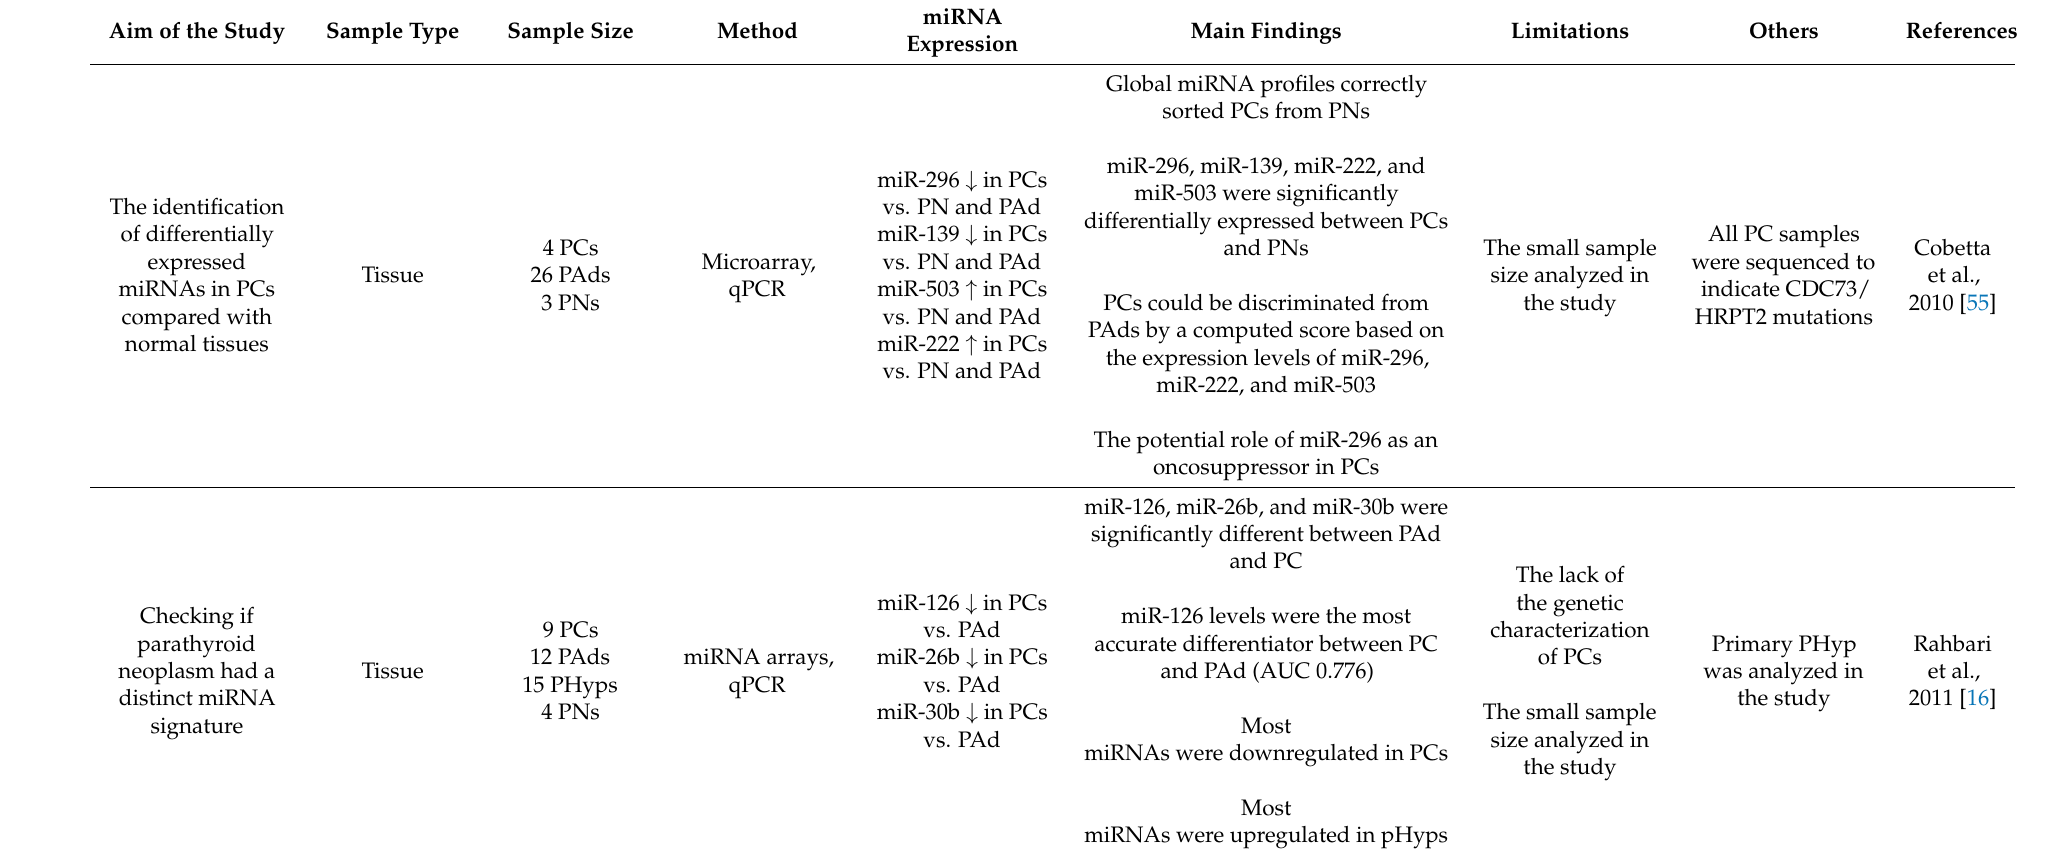
Table 1. Summary of studies looking at miRNA expression in